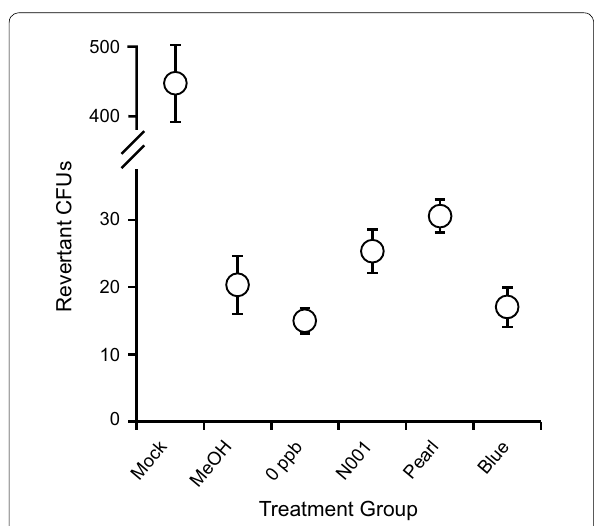
Fig. 2 Mutagenicity of breakdown products from AFB 1 -contaminated maize treated with P. ostreatus. Number of revertant CFUs when exposed to the extraction solvent without AFB 1 (MeOH), or extracts from untreated (mock) and treated (N001, Pearl and Blue) maize with initial AFB 1 concentrations of 2500 ng g − 1 , and from uncontaminated (0 ng g − 1 ) maize. Whiskers show standard